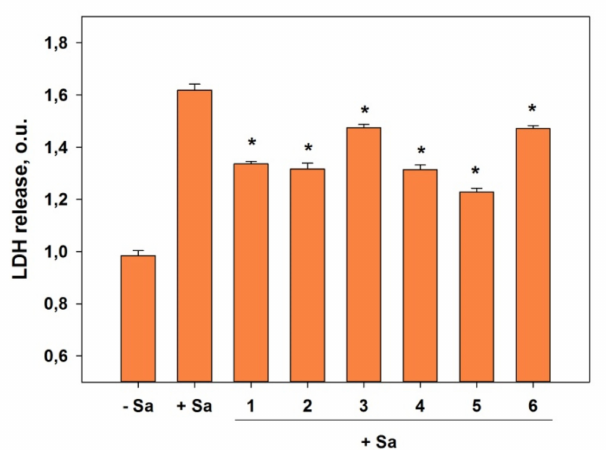
Figure 8. Effect of acrucipentyns A–F ( 1 – 6 ) on LDH release from human keratinocytes HaCaT co- cultivated with Staphylococcus aureus (Sa) for 48 h. All compounds were tested at a concentration of 10 µ M. All experiments were performed in triplicates and data are presented as a mean ± SEM. The difference between control (without Sa) and HaCaT/Sa co-cultivation was statistically significant with p < 0.05 (one-way ANOVA test). Asterisk (*) indicates significant differences ( p < 0.05) between HaCaT/Sa without compounds and HaCaT/Sa with compounds